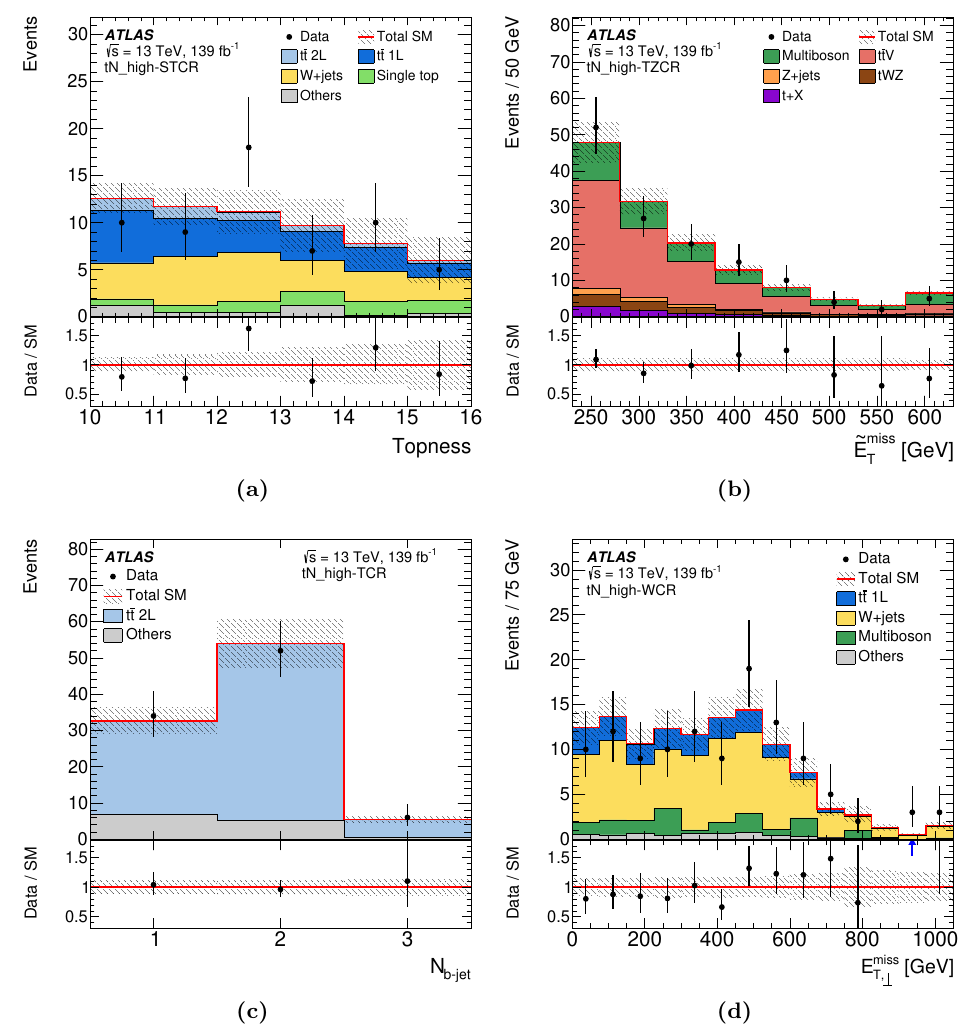
Figure 4. Selected kinematic distributions in tN_high CRs: (a) topness in the STCR, (b) ˜ E miss in T the TZCR, (c) N b -jet in the TCR, (d) E miss in the WCR. The distributions shown are post-fit, i.e. T , ⊥ each background is scaled by a normalisation factor obtained from a background-only likelihood fit to the CRs (see table 14). The hatched area around the total SM prediction and the hatched band in the Data/SM ratio include all statistical and systematic uncertainties. The last (first) bin contains overflows